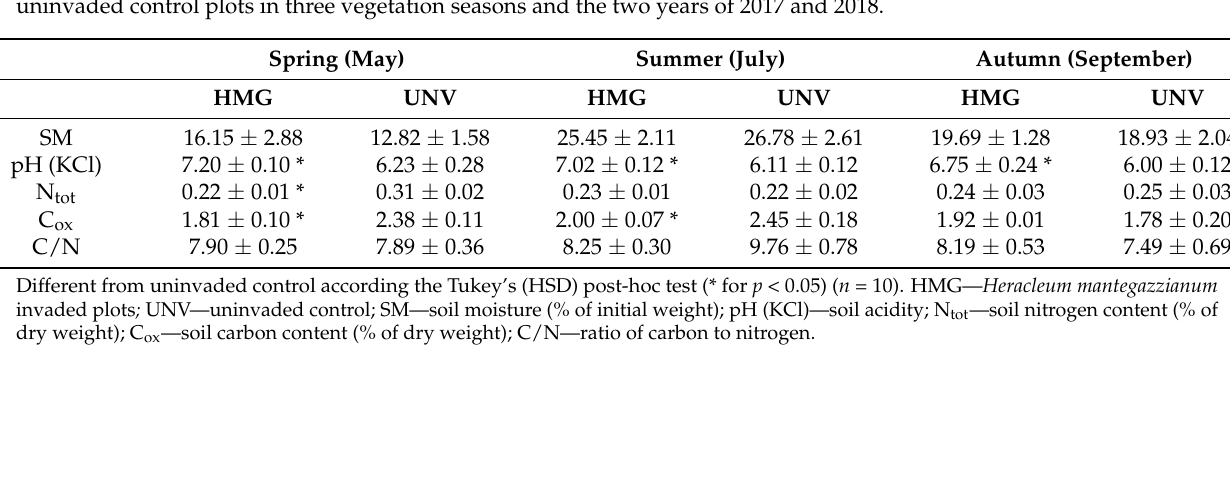
Table 1. Soil physico-chemical properties (mean ± S.D.) of the investigated plots of Heracleum mantegazzianum invaded and uninvaded control plots in three vegetation seasons and the two years of 2017 and 2018.